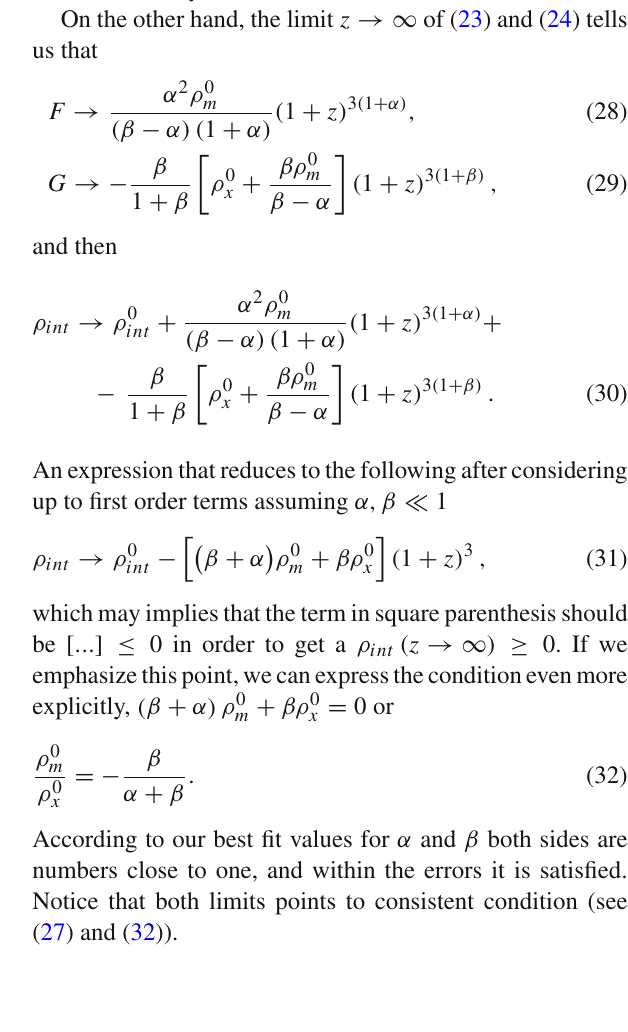
Fig. 2 Herewedisplaytheconfidencecontours–atoneandtwosigmas –forthetwofreeparametersinthefit: (cid:10) and γ definedinthetext.Notice that the data suggest a non zero γ at 1 σ but at 2 σ does not exclude the zero